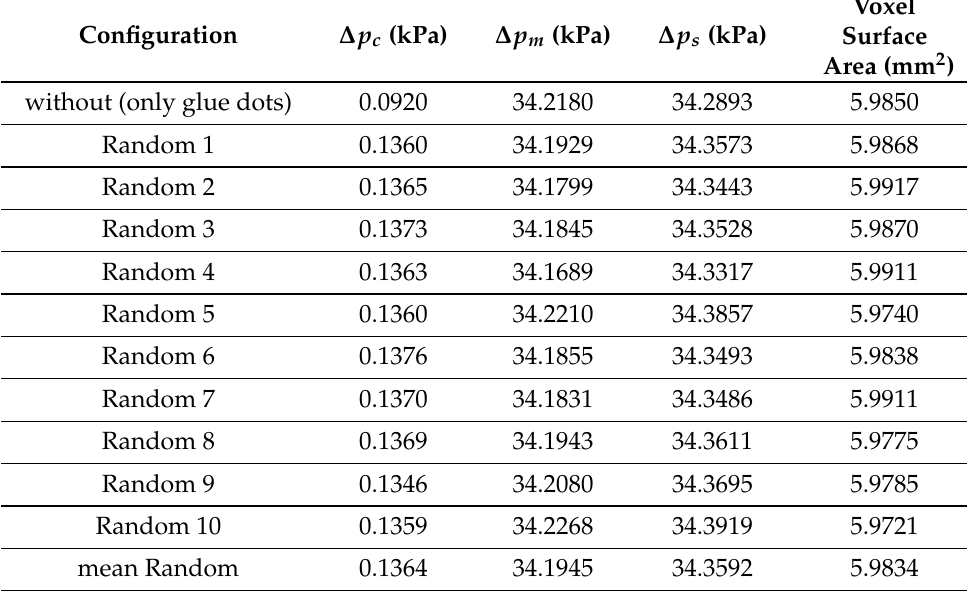
Table 3. Simulation results for positioning microcapsules on glue dots on the membrane